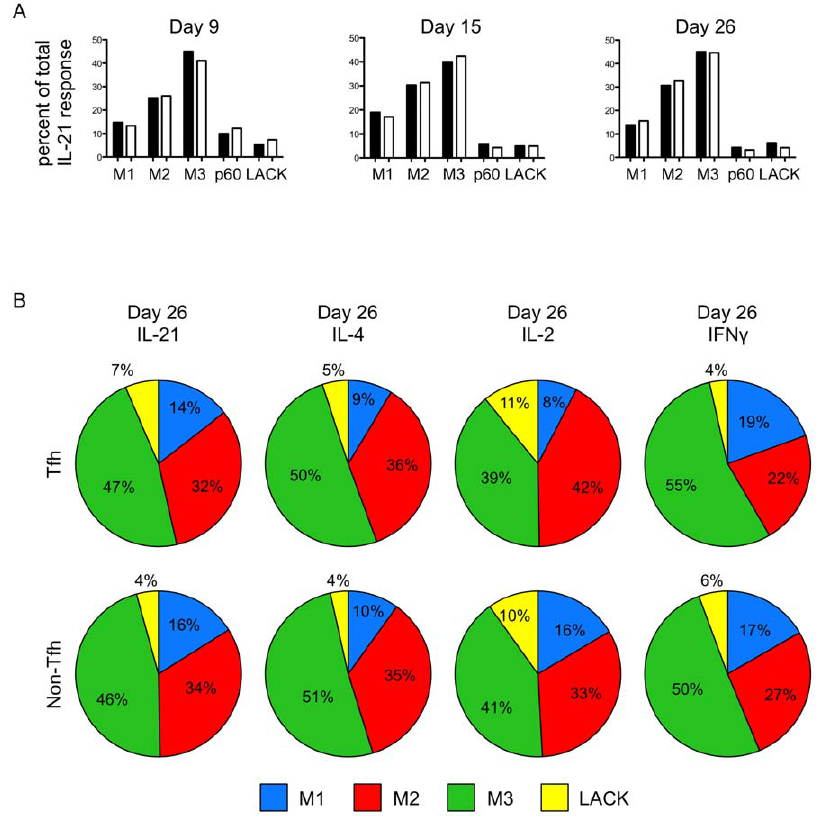
Figure 8. The immunodominance hierarchies established within the Tfh and non-Tfh populations during the peak of the immune response are maintained late in the immune response. As previously described, peptide-specific Tfh and non-Tfh cells responses were measured with IL-21 ELISPOT assays on day 9, 15 and 26 after MalE-LACK(I . A) protein immunization (A). On day 26 after protein immunization, peptide-specific Tfh and non-Tfh responses were measured with IL-21, IL-4, IL-2, and IFN c ELISPOT assays. The percent of peptide responses are shown in B. Data shown represent a single experiment from cells pooled from 40–80 mice per time point.